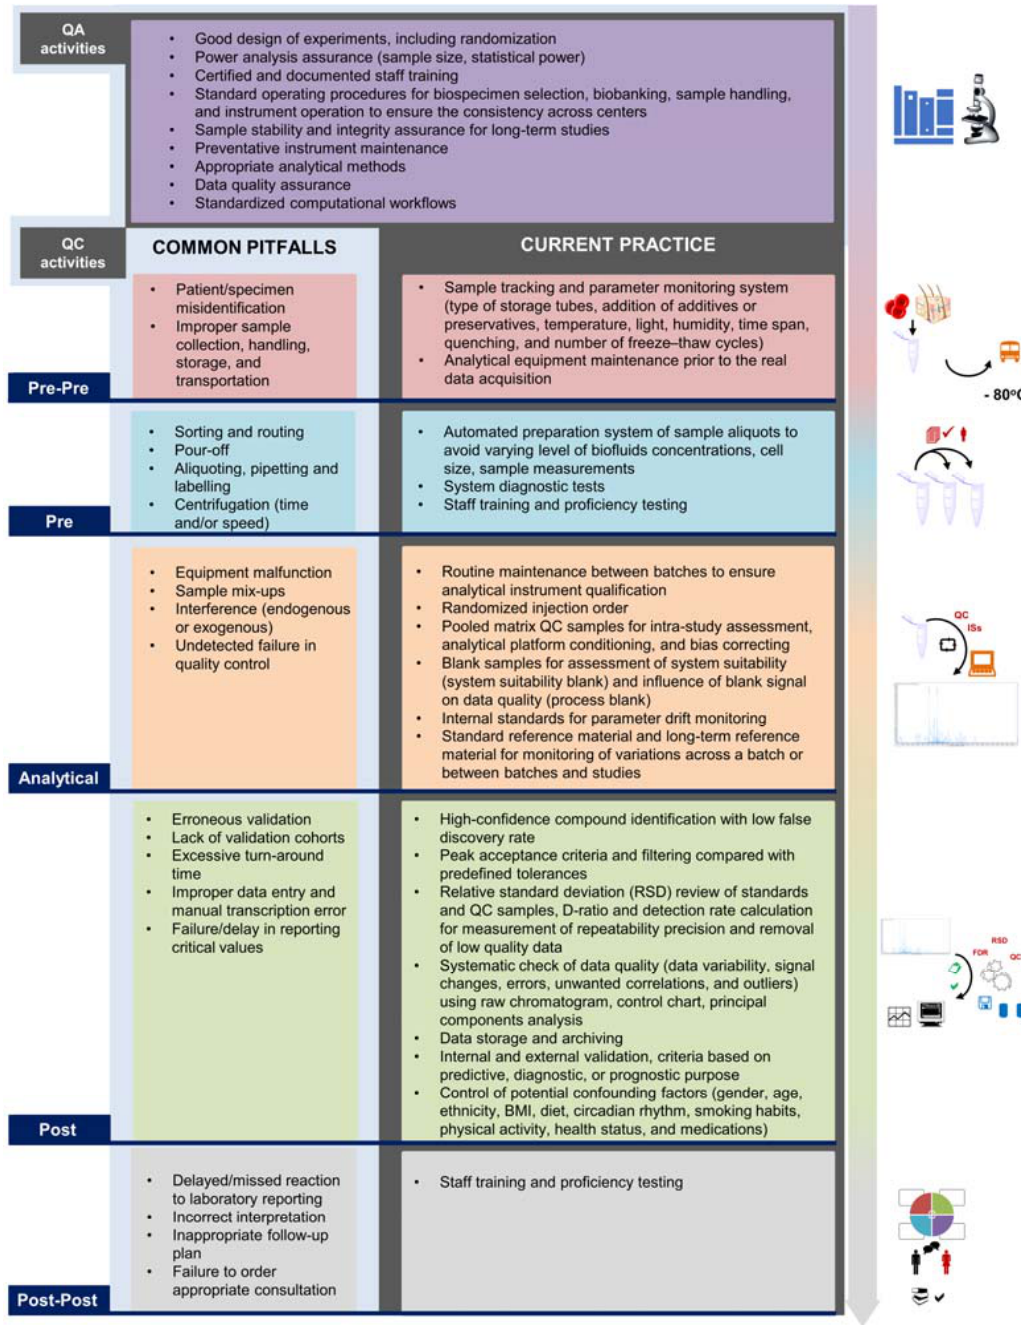
Figure 2. Quality assurance (QA) / quality control (QC) procedures following the novel five-step classification: pre-pre-analytical, pre-analytical, analytical, post-analytical, and post-post-analytical phases. QA activities are considered before while QC activities are undertaken during and after sample collection. The first column of QC is based on the content of five-step laboratory errors suggested by Plebani et al. [67]. The second column displays current QC techniques and activities recommended to be carried out in clinical metabolomics. Table 2. Additional recommendations to ensure QA/QC procedures in metabolomics and lipidomics study at clinical and epidemiological scale.